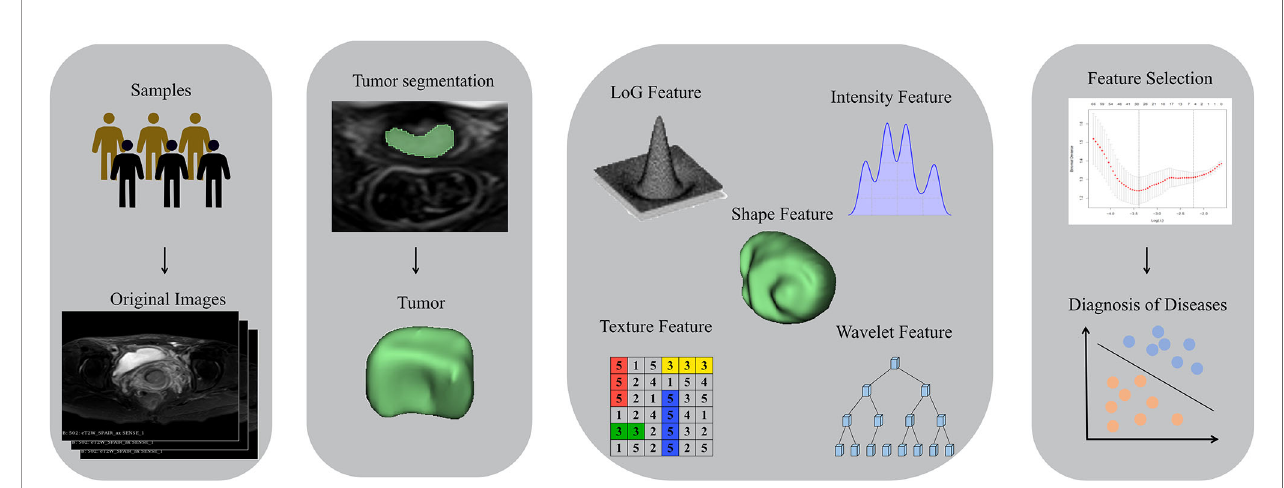
FIGURE 3 | Work fl ow of radiomics analysis. T2WI images were collected. Regions of interests (ROI) of the tumor lesions were manually delineated. Radiomics features were extracted. Discriminative features were selected by the LASSO regression model. Prediction model was constructed by radiomics signature; ROC curves were performed for further statistical